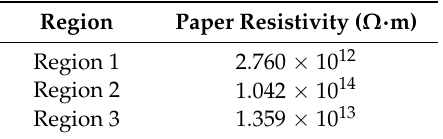
Table 6. Iterative results with rounded i nsulation resistance